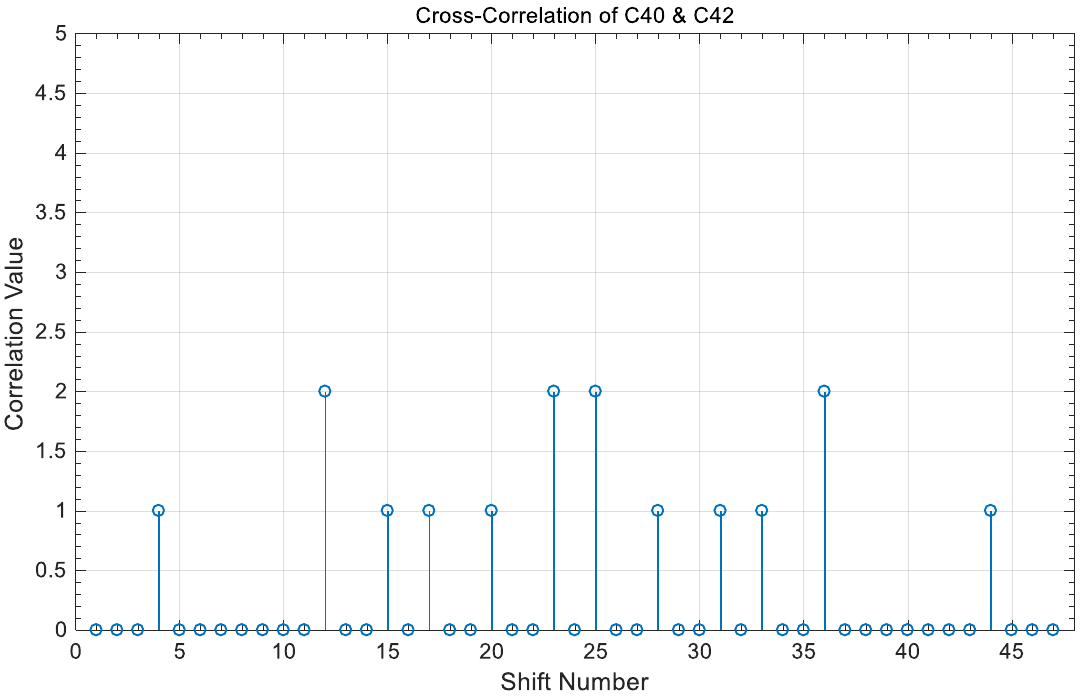
Figure 9. Cross-correlation between 𝐶 40 and 𝐶 42 sequences in same group, 𝑃 1 = 5 and 𝑃 2 = 7.